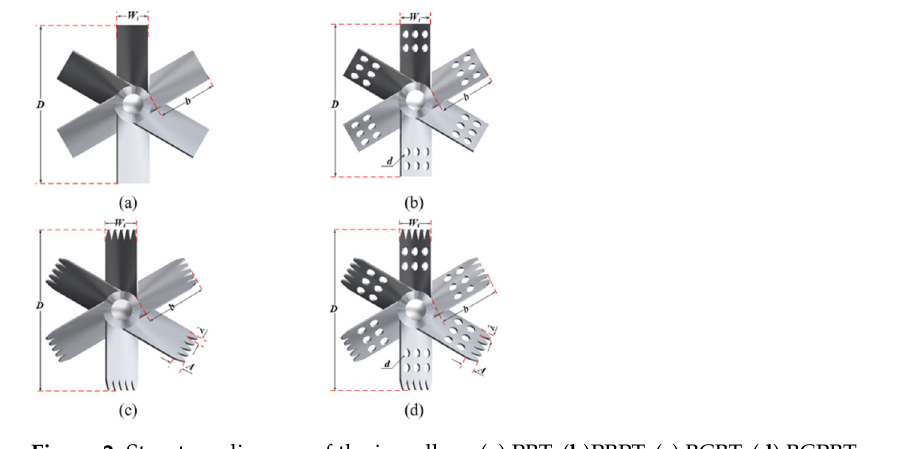
Figure 2. Structure diagram of the impellers. ( a ) PBT, ( b )PBPT, ( c ) BCBT, ( d ) BCPBT. Table 1. Dimensions of tank and impeller.